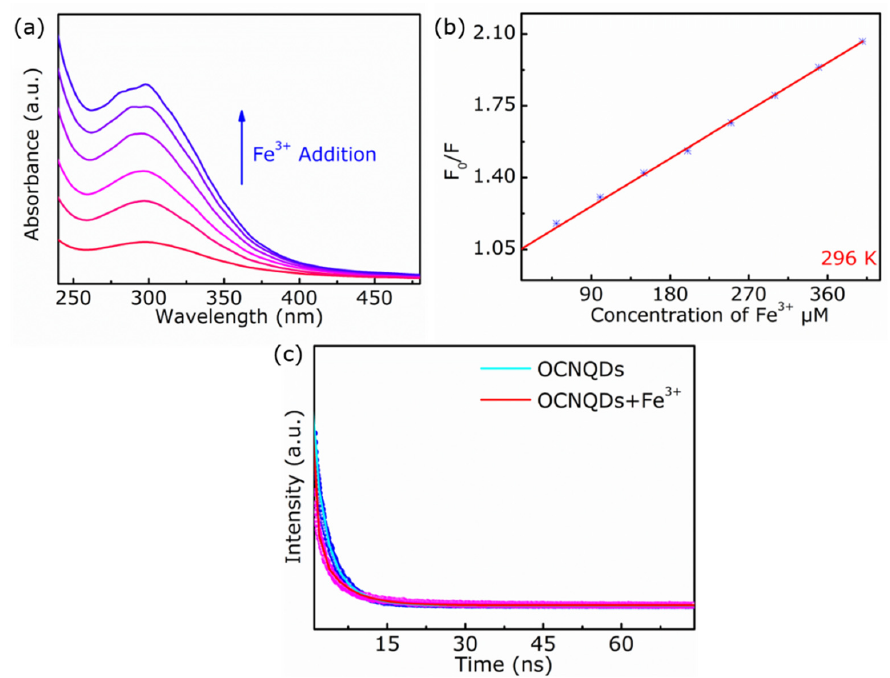
Figure 7. ( a ) The UV–vis spectra of OCNQDs in the absence and presence of Fe 3+ (0–3000 μ M). ( b ) Stern–Volmer plots describes the dependency of the fluorescence intensities on the Fe 3+ concentra- tion over the range of 0–400 μ M. ( c ) Fluorescence lifetime of OCNQDs in the presence or absence of Fe 3+ .